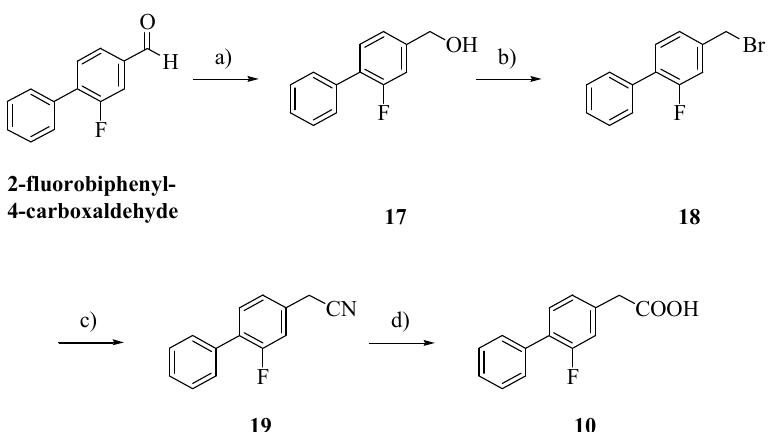
Scheme 2. Synthesis of FLU derivative 10